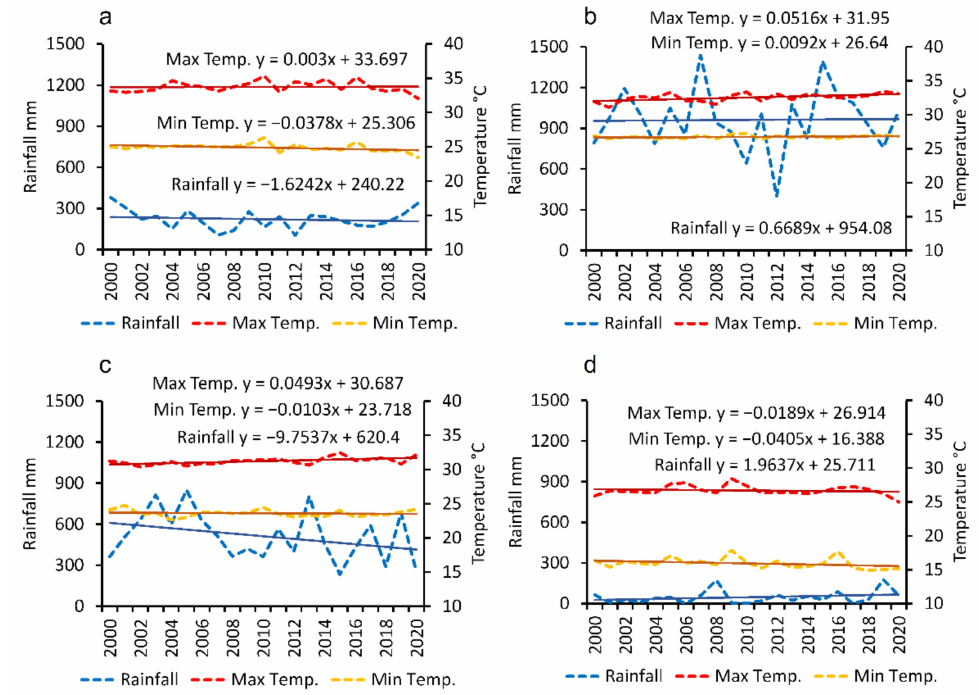
Figure 8. Annual rainfall, maximum temperature and minimum temperature variability in ( a ) summer, ( b ) monsoon, ( c ) post-monsoon, and ( d ) winter season during 2000–2020 in the